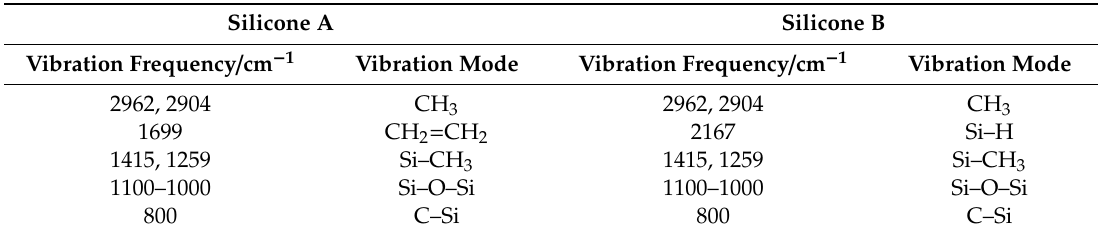
Figure 7. The FTIR spectrum of silicones and their molecular formula ( a ) silicone A; ( b ) silicone B. Table 1. Characteristic peaks of silicone A and B in the FTIR spectrum. Table 1. Characteristic peaks of silicone A and B in the FTIR spectrum.